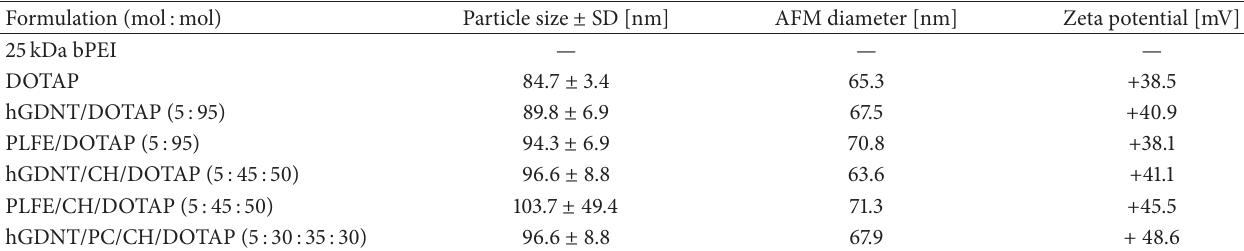
Table 1: Composition and physicochemical properties of polymer and liposomal